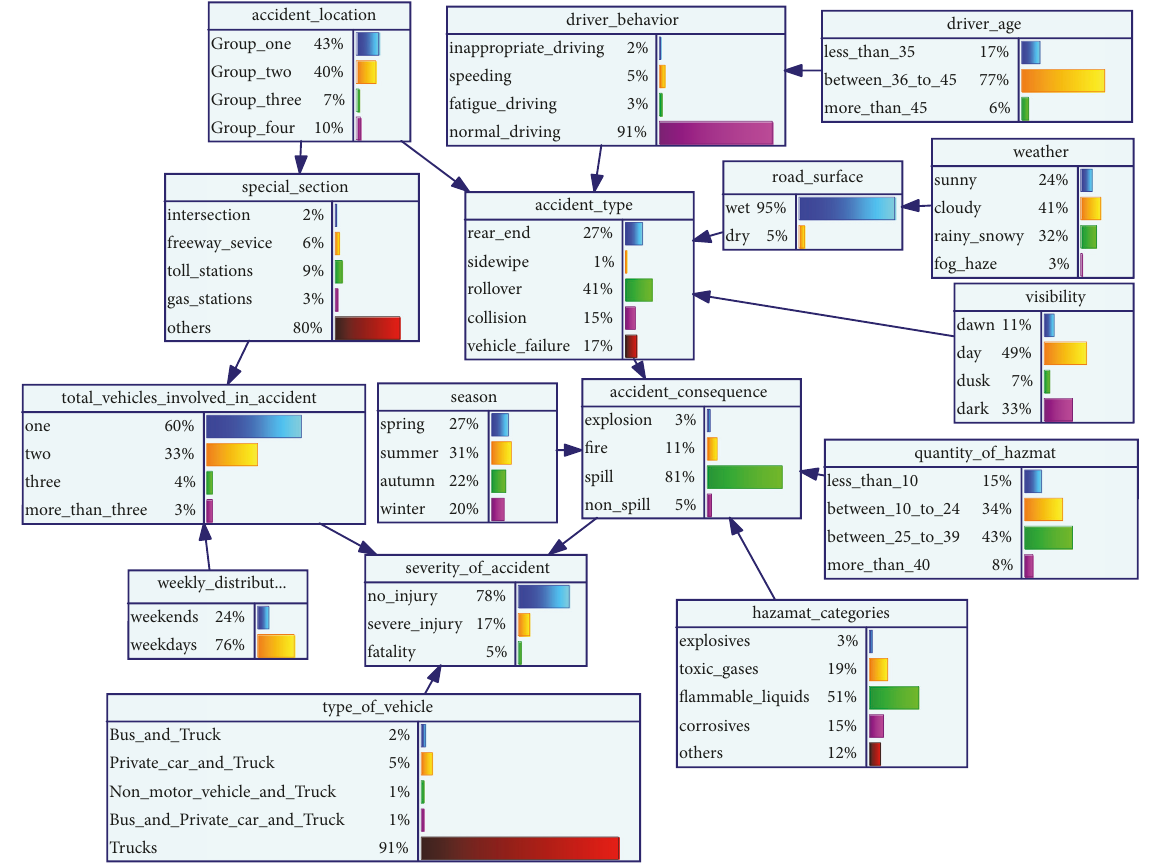
Figure 3: The Bayesian network model after parameter learning in Genie